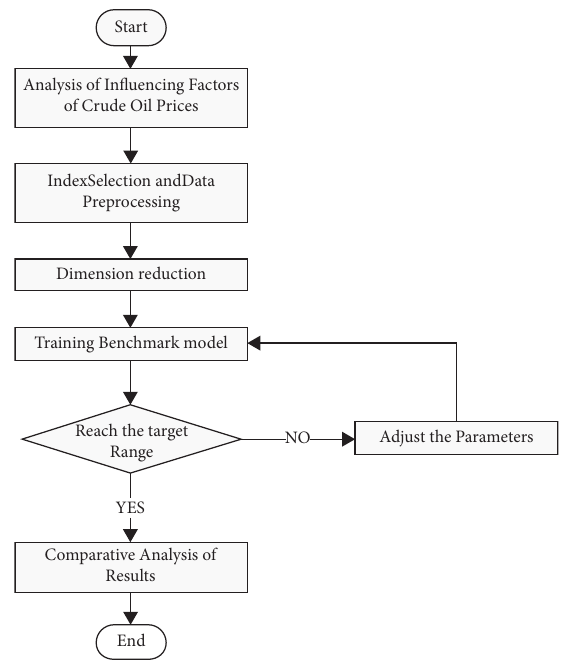
Figure 3: Crude oil price prediction